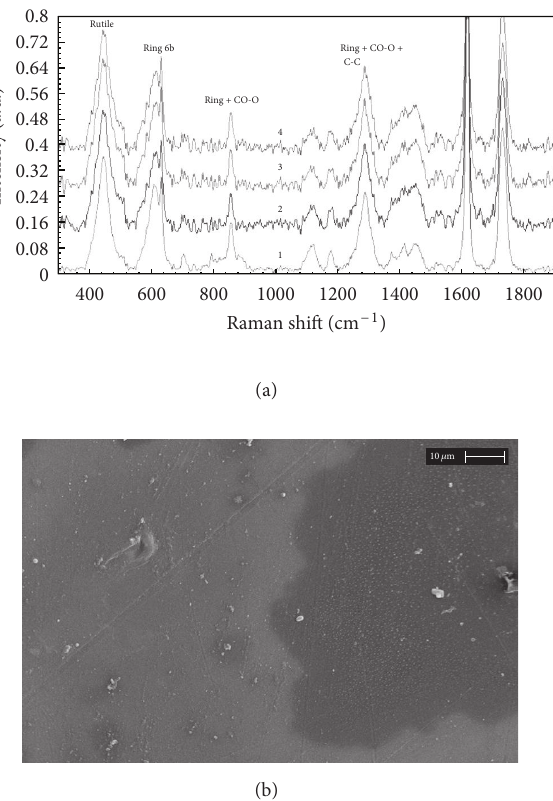
F 4: Spectra perpendicular to the PET with macromode analyses of the samples using an FT-Raman